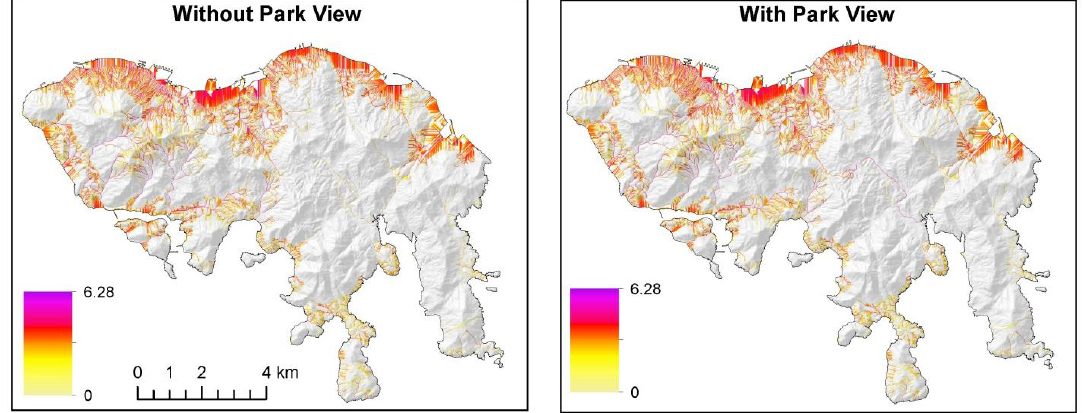
Figure 11. Changes in urban runoff due to the development of the Parkview residential project. The values indicate the accumulated number of pixels contributing runoff to each pixel, based on the digital elevation model, and on the distribution of built-up areas. Values were log